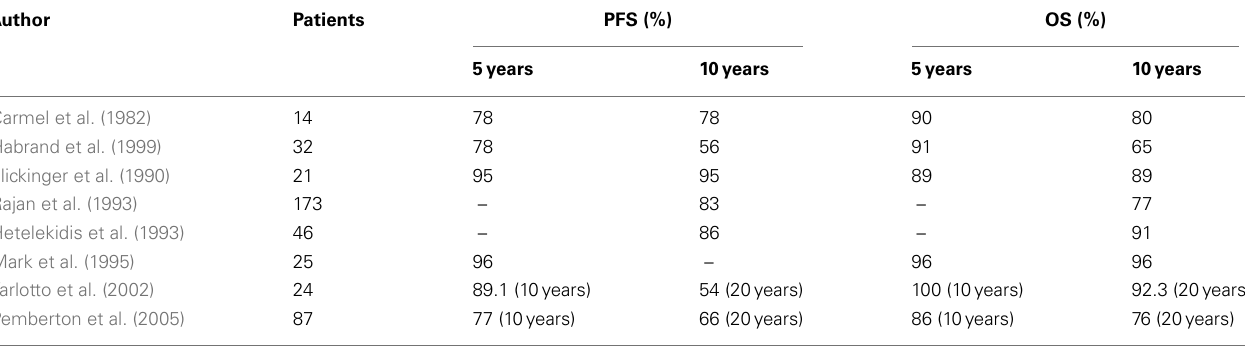
Table 1 | Post-operative radiotherapy in craniopharyngioma/conventional techniques (tumor control and survival).